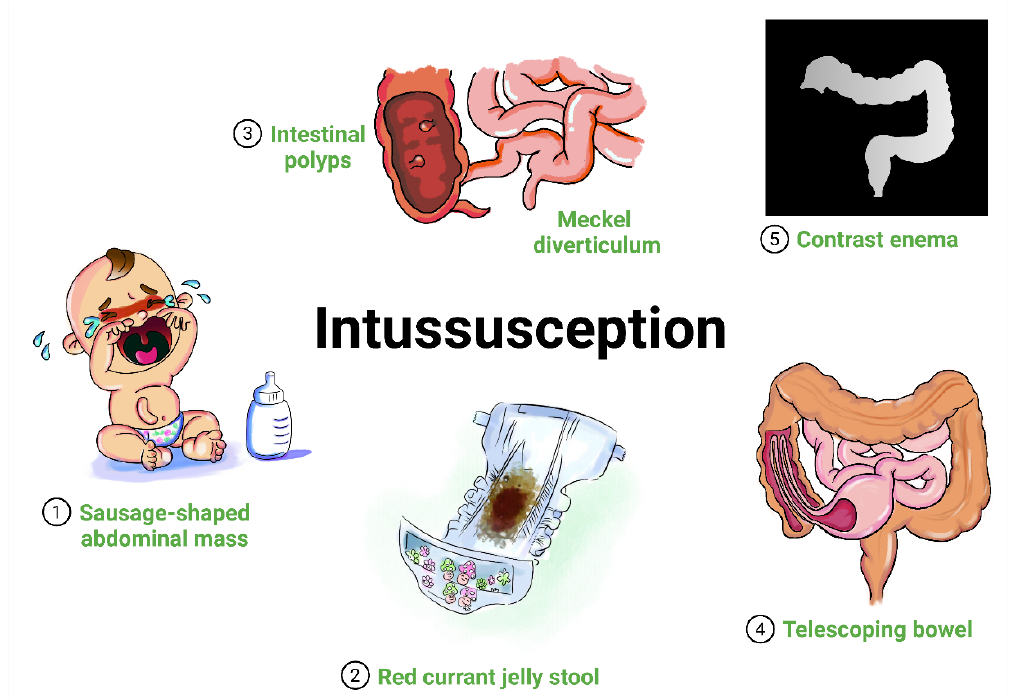
Figure 1. Graphical representation of ISN in children. ISN classically presents in an infant or toddler with (1) sudden onset of intermittent, severe, and progressive abdominal pain and palpable sausage-shaped abdominal mass, and/or (2) red currant jelly stool. ISN may possibly be due to (3) lead points (such as intestinal polyps or Meckel diverticulum). ISN refers to (4) the invagination (telescoping) of a part of the intestine into a more distal segment (proximal segment is known as the intussusceptum and the distal segment into which it telescopes is known as the intussuscipiens). Radiography findings may reveal a (5) lack of perfusion in the intussusceptum, indicating the development of